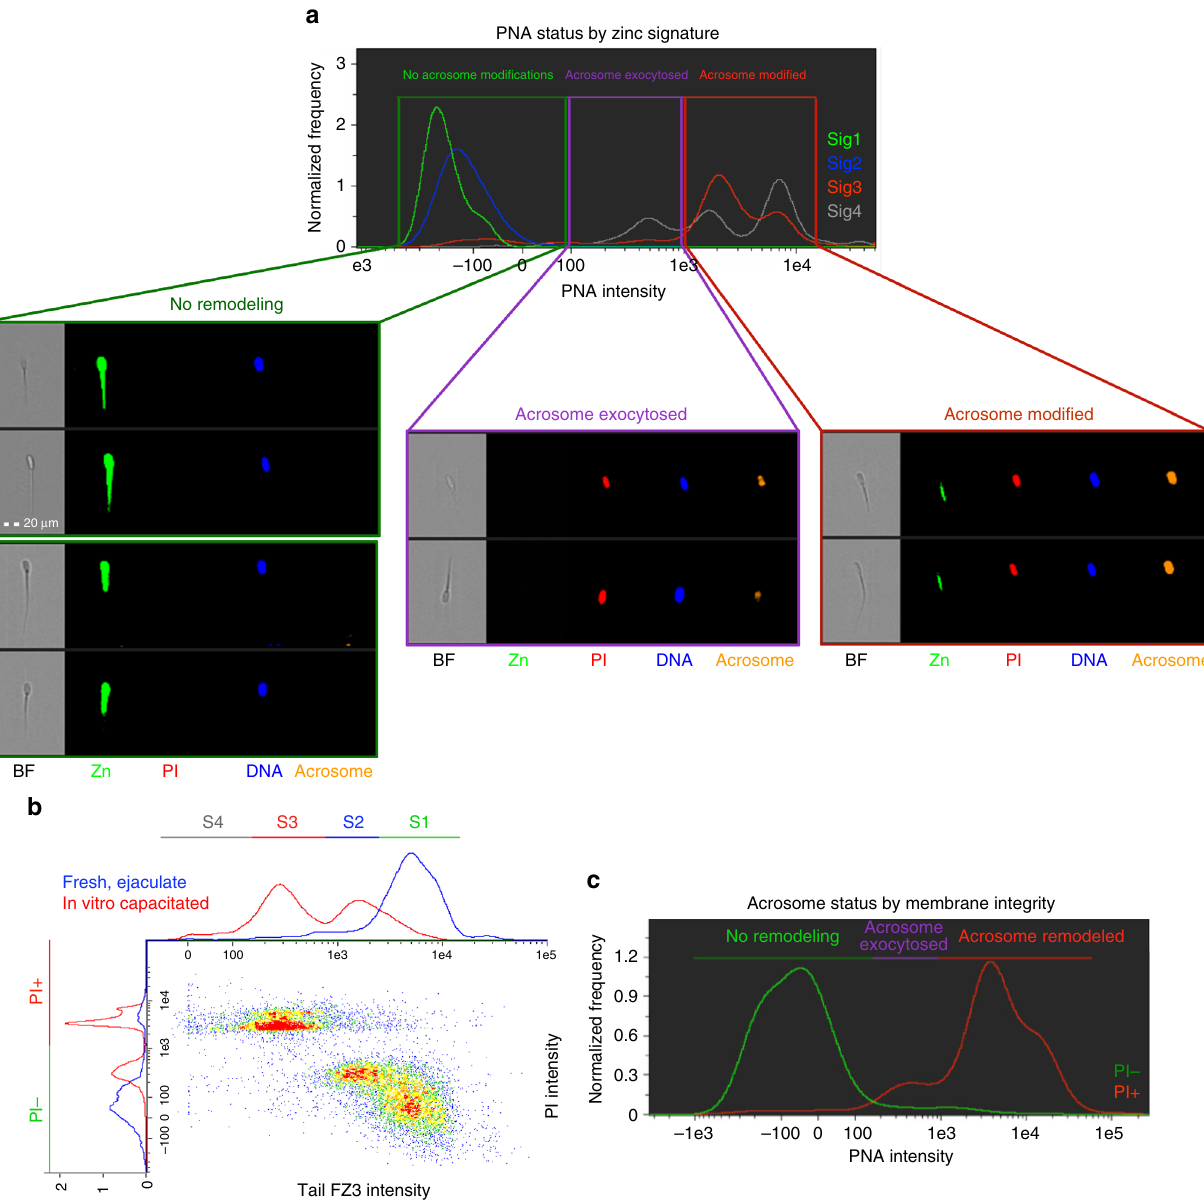
Fig. 3 Acrosomal status and membrane integrity of zinc signature. a Most spermatozoa in zinc signature 1 and 2 states had no capacitation-like acrosomal remodeling compared to zinc signature 3 and 4 ( P < 0.0001; see Table 1). Capacitation-like acrosomal remodeling was most prevalent with zinc signatures 3 and 4 compared to zinc signatures 1 and 2 ( P < 0.0001; 4 biological replicates; 10,000 spermatozoa analyzed per treatment). Acrosomal exocytosis occurred within the subpopulation of spermatozoa with zinc signature 4 and was greater than zinc signatures 1, 2, and 3 ( P < 0.001; scale bar: 20 μ m). b Zinc signature status corresponds with PI plasma membrane integrity in fresh (blue) and IVC spermatozoa (red). c As sperm plasma membrane integrity decreased, acrosomal remodeling and exocytosis occurred. P -values determined by the general linear model procedure in SAS